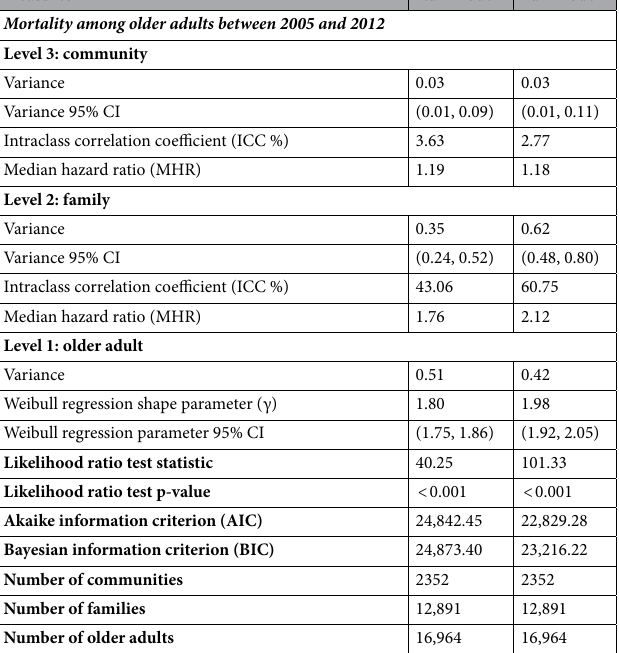
Table 4. Random-effect parameters from three-level Weibull random intercept survival regression models of mortality among older adults in India. (a) CI, confidence interval; (b) Null model, Model without any explanatory covariates; Full model, Model with all explanatory covariates; (c) Likelihood ratio tests were performed against single-level Weibull survival regression models with the same covariates